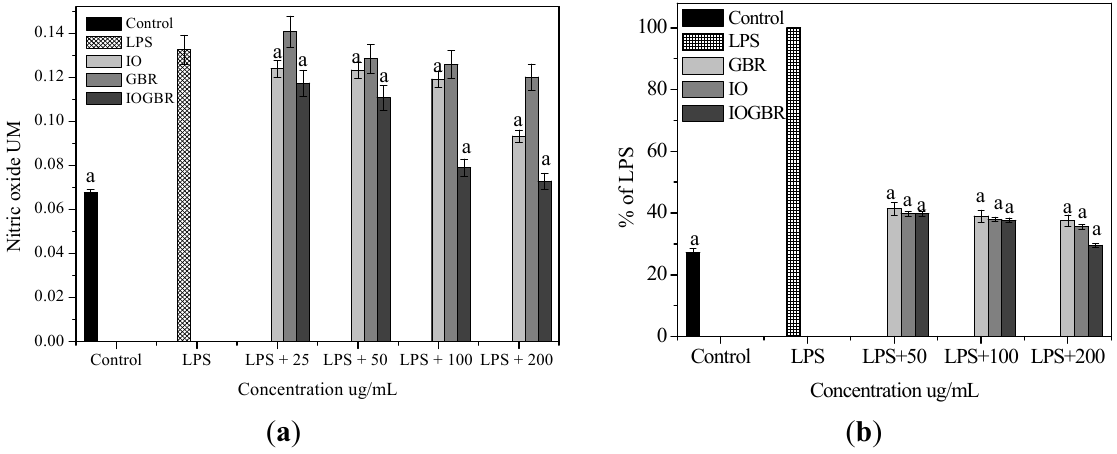
(GBR) and Inonotus obliquus grown on germinated brown rice (IOGBR) on LPS-induced NO production Raw 264.7 ( b ) Dose dependent PGE germinated brown rice (GBR) and Inonotus obliquus grown on germinated brown rice (IOGBR).